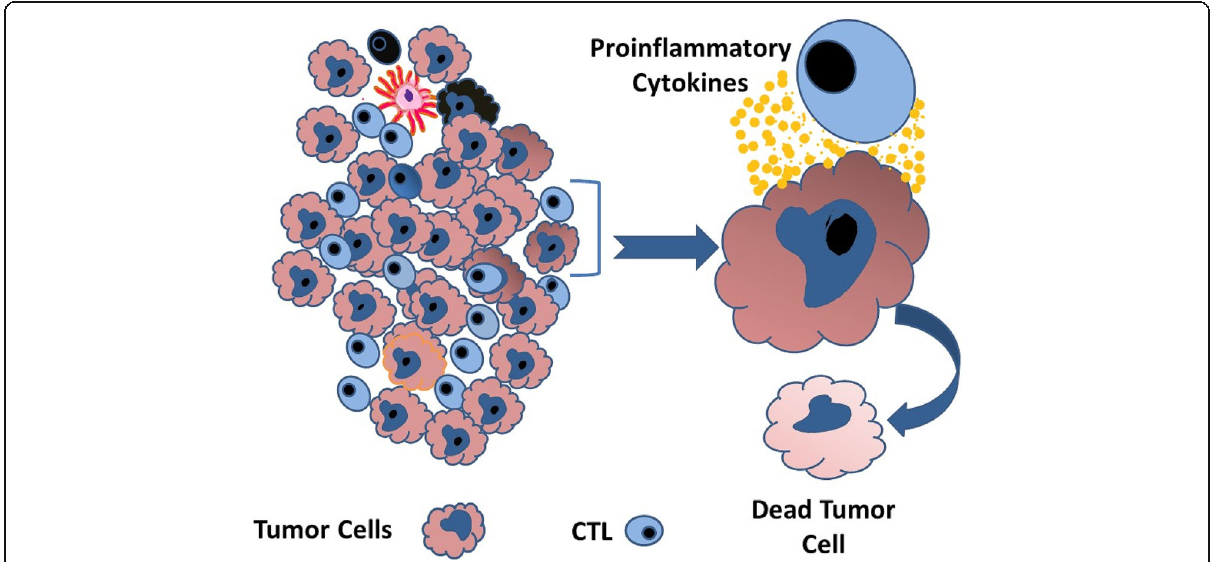
Fig. 6 Activated lymphocytes invade the tumor microenvironment and seek cancer cells for destruction. To kill the cancer cells, ATC produces pro-inflammatory cytokines, which may accumulate and alter the tumor ’ s micro-environment. As a result, cancer cells increase the expression of PD-L1 on the cell